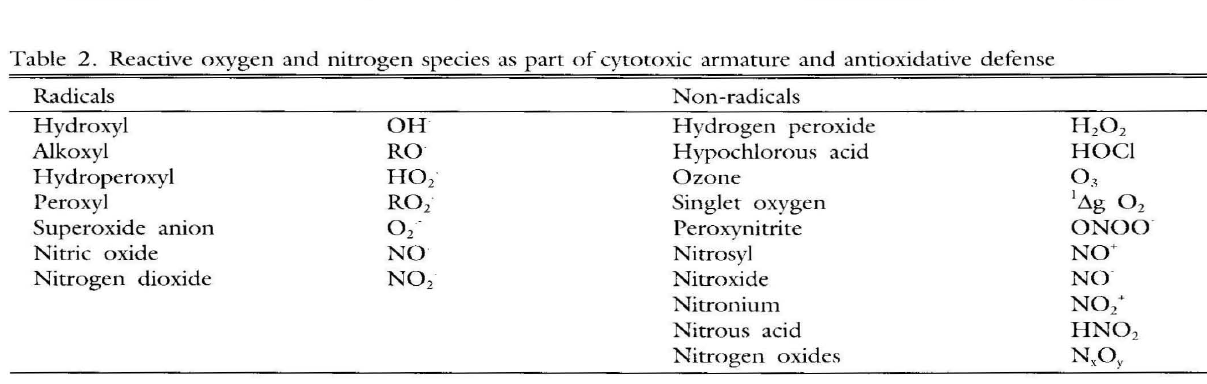
Table 2. Reactive oxygen and nitrogen species as part of cytotoxic armature and antioxidative defense Radicals